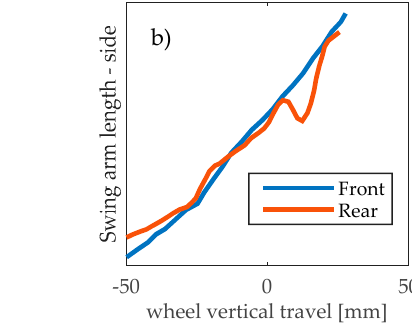
Figure 5. Partial Suspension Parameter Measurement Machine (SPMM) kinematics and compliance (K&C) test results: on the left, variation of the swing arm roll instant, centre position for the front-right and rear-right suspensions with respect to the relative body roll (the left side is omitted for sake of space). On the right, variation of the swing arm pitch instant. centres position for front and rear suspensions with respect to the vertical wheel translation. Values on Y-axis are omitted due to confidentiality.